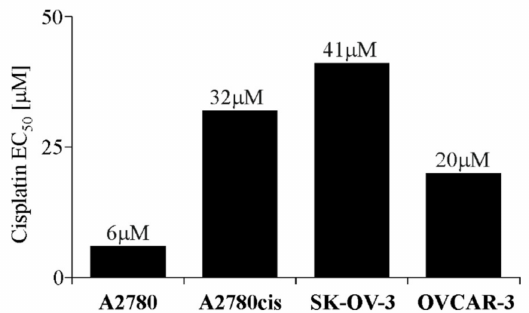
Figure 1. Effective concentration of cisplatin (EC 50 ) for A2780, A2780cis, SK-OV-3 and OVCAR-3 cell lines. All cell lines were cultured with various concentrations of cisplatin (1–200 µ M) or not (control) for 48 h. Cell viability was determined with MTT assay and is presented as the EC 50 value for each cell line, calculated from three independent experiments ( n =